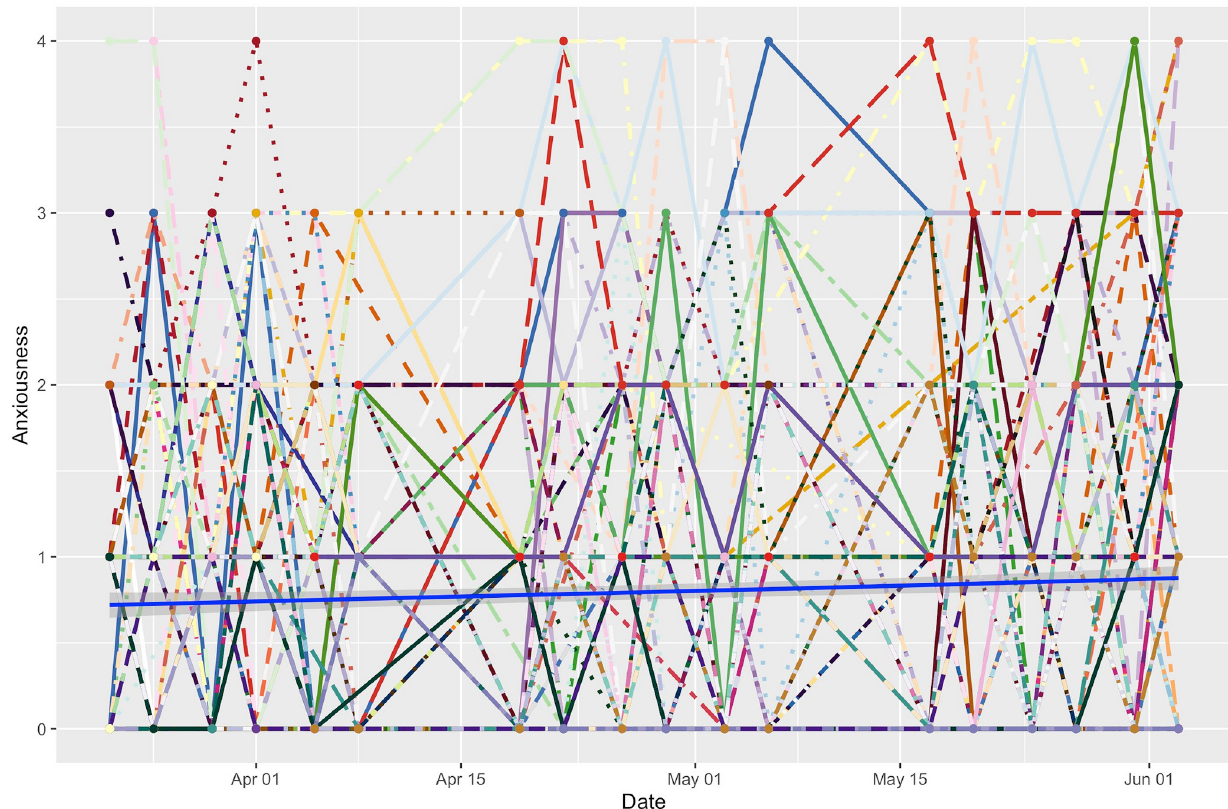
Fig 4. Heterogeneity in individuals’ levels of anxiety (reported in ESM). Individual trajectories of anxiety are shown in different line types and colors (dotted versus solid lines represent different participants). Although the mean level of anxiety is 1 on a scale of 0–4, the significant variation in responses invites examination of individuals and